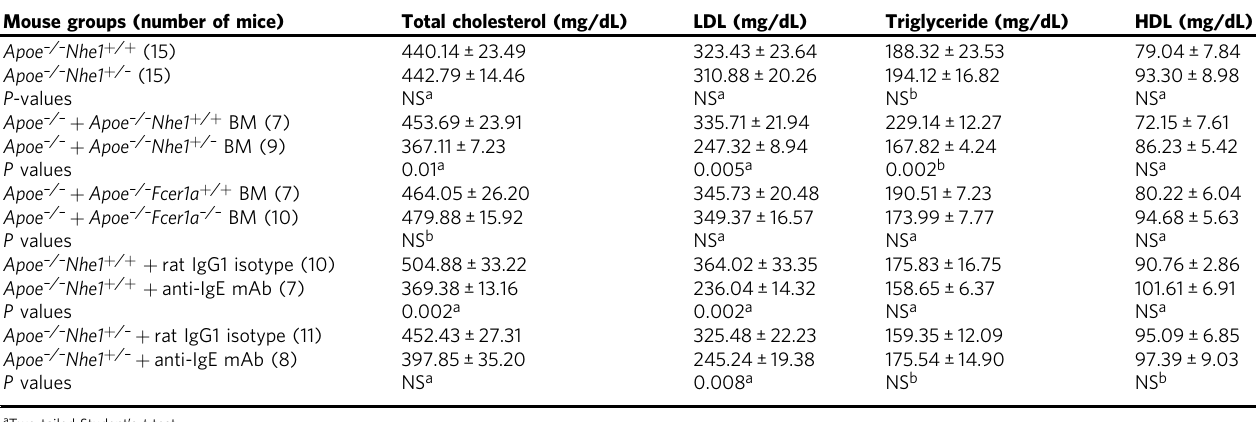
Table 1 Plasma lipid and lipoprotein levels from different groups of mice Mouse groups (number of